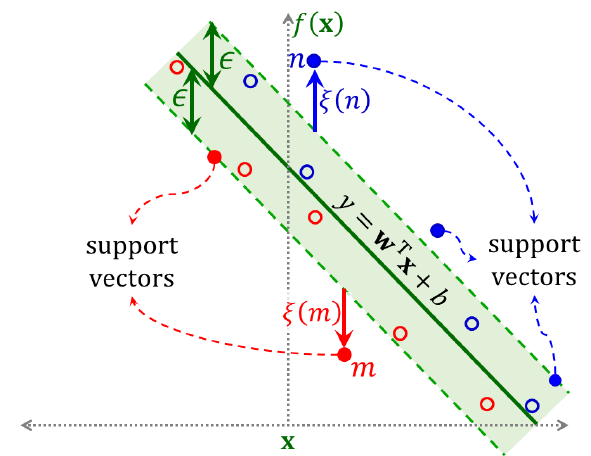
Figure 8. Linear support vector regression. The regression line y = w T x + b (solid green), and the (cid:101) region (shaded green) of zero penalties around it, are shown. Also shown are samples (small circles) including the support vectors (filled circles) indexed m and n